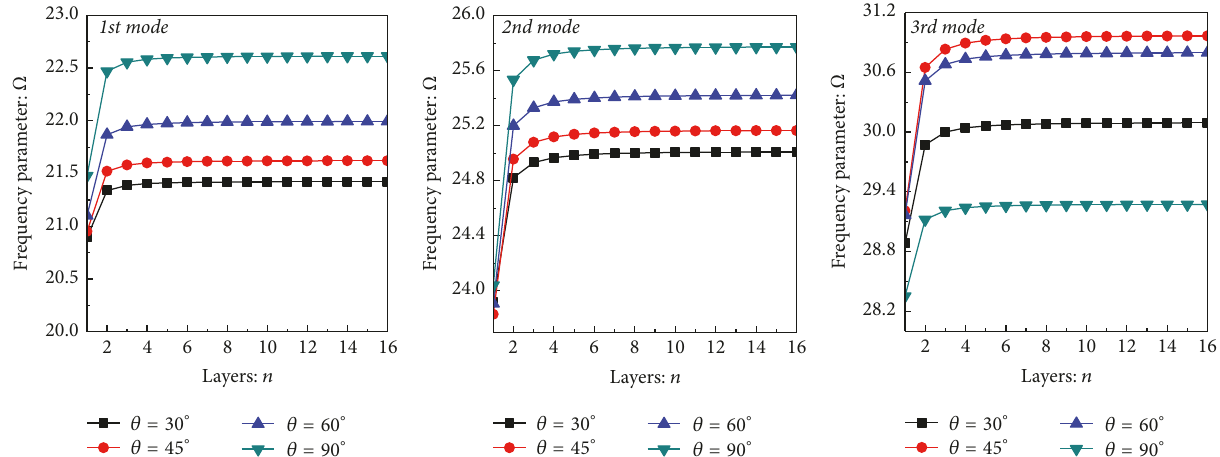
Figure 8: Frequency parameters Ω versus number of layers 𝑛 for a [0/𝜃] 𝑛 layered plate with middle-points supported boundary conditions.